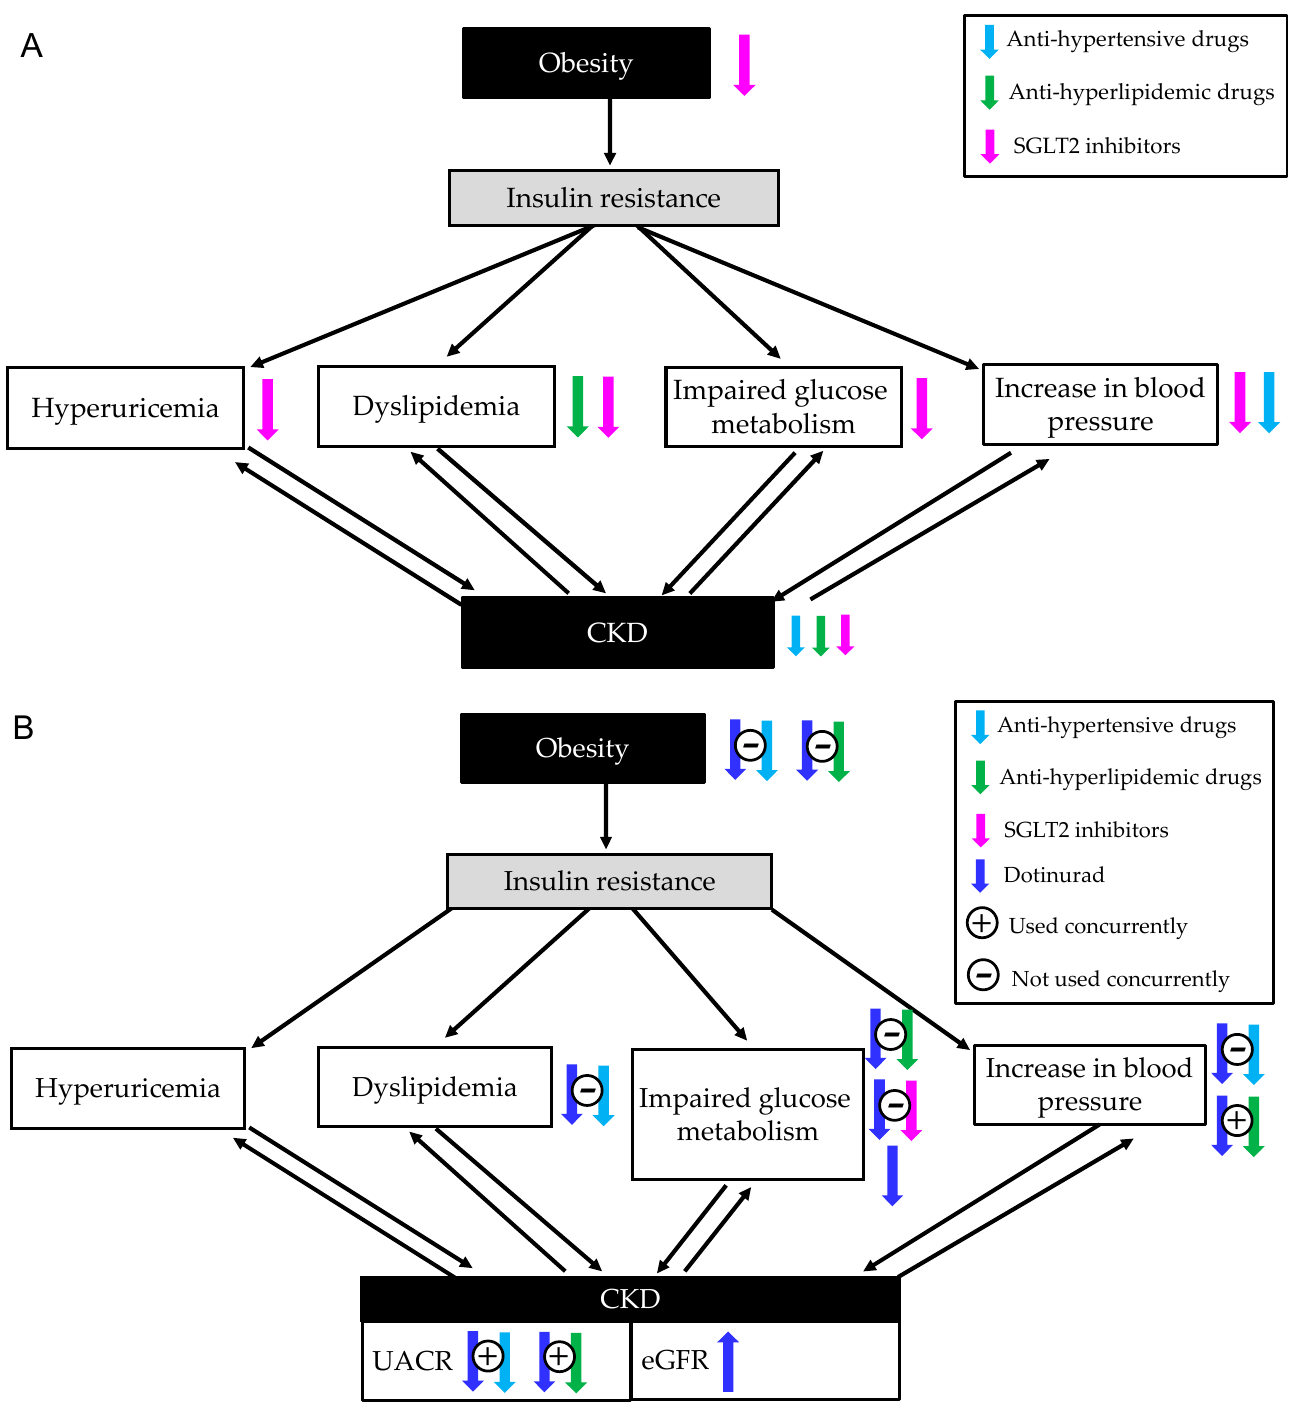
Figure 9. Relation of metabolic syndrome components and hyperuricemia with CKD, and effects of anti-hypertensive and anti-hyperlipidemic drugs and SGLT2 inhibitors on metabolic parameters and CKD ( A ). Effects of dotinurad with and without anti-hypertensive and anti-hyperlipidemic drugs and SGLT2 inhibitors on metabolic parameters and CKD ( B ).